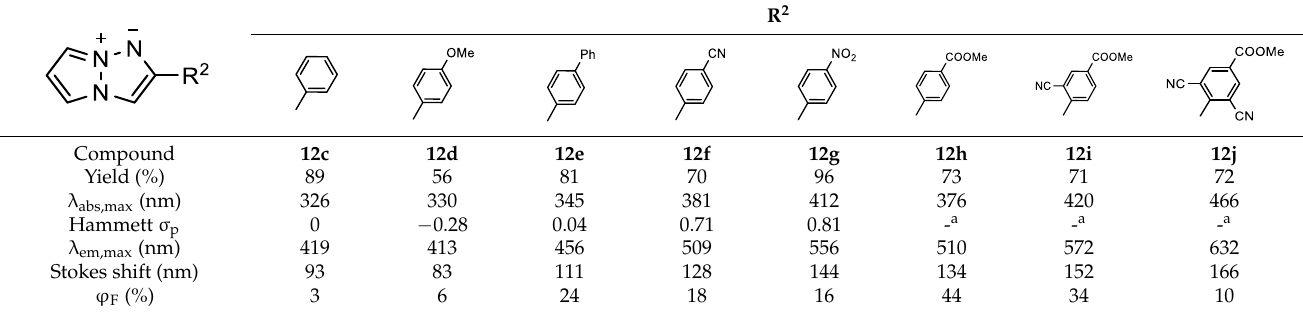
Table 1. Fluorescence properties and reaction yields of selected 2-substituted TAPs 12c – g in DCM. R 2